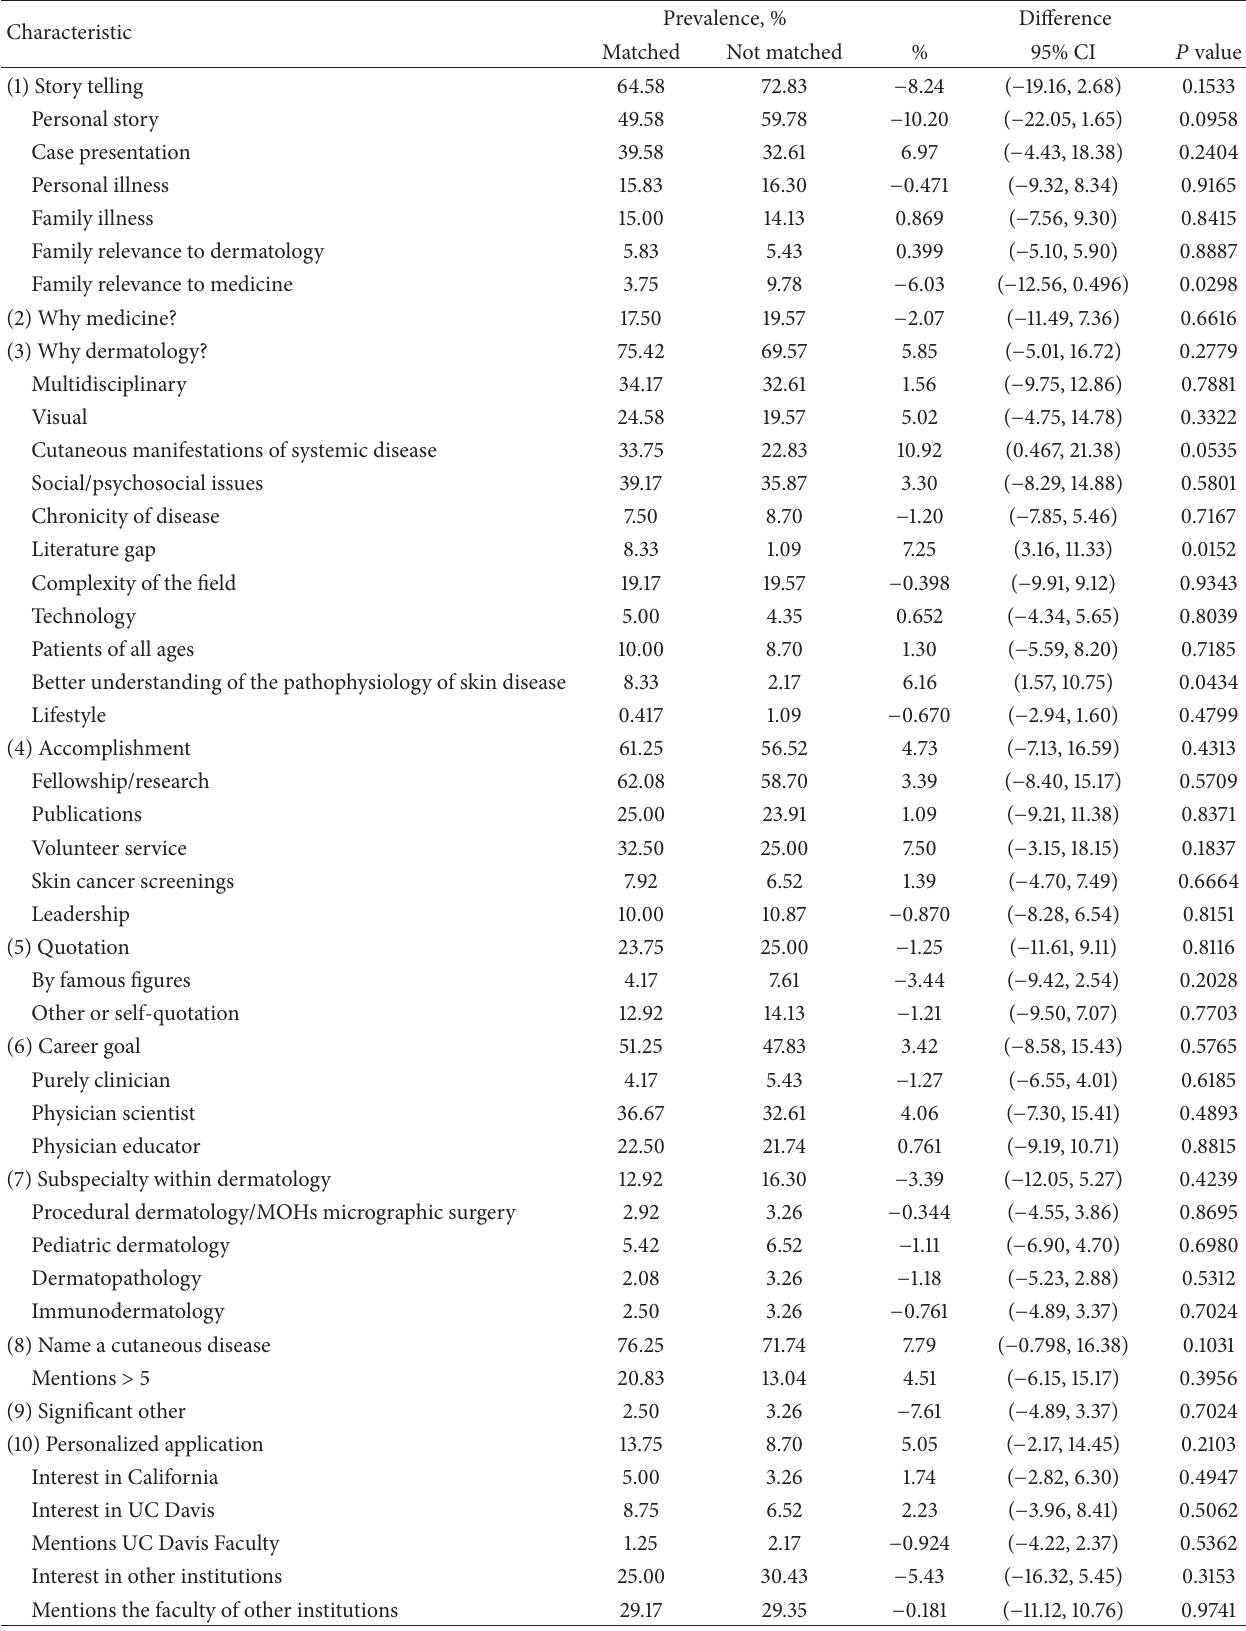
Table 1: Characteristic themes of content that appeared in the personal